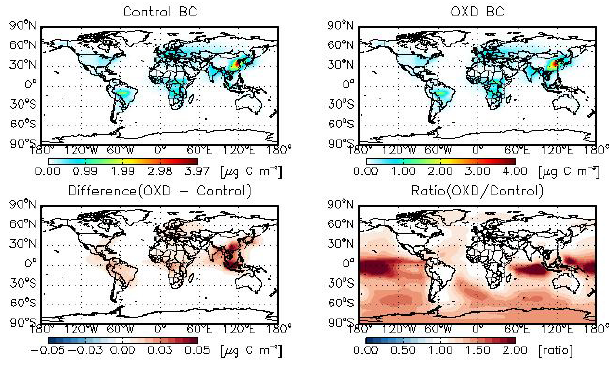
Fig. 3a. Model simulated annual mean surface BC concentrations from the sensitivity run versus the control run. (Upper left) BC con- centrations from the control run; (upper right) BC concentrations from the sensitivity run using the oxidation aging scheme; (lower left) differences between the sensitivity run and control run results; (lower right) ratio between sensitivity run and control run